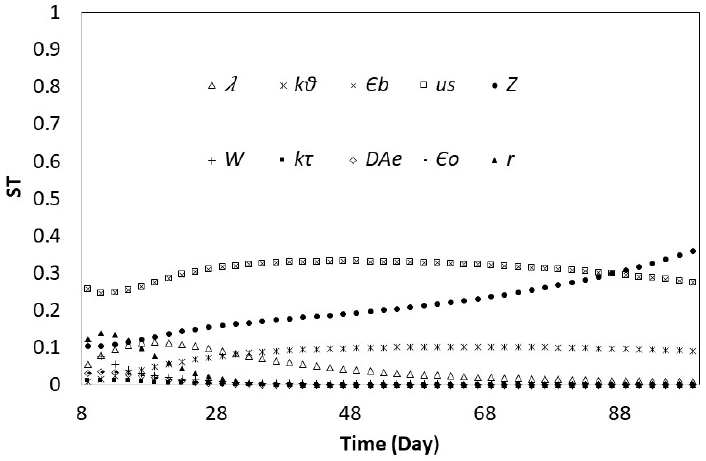
Figure 3. Global sensitivity analysis (GSA) of the model with a heap height equal to 600 cm.